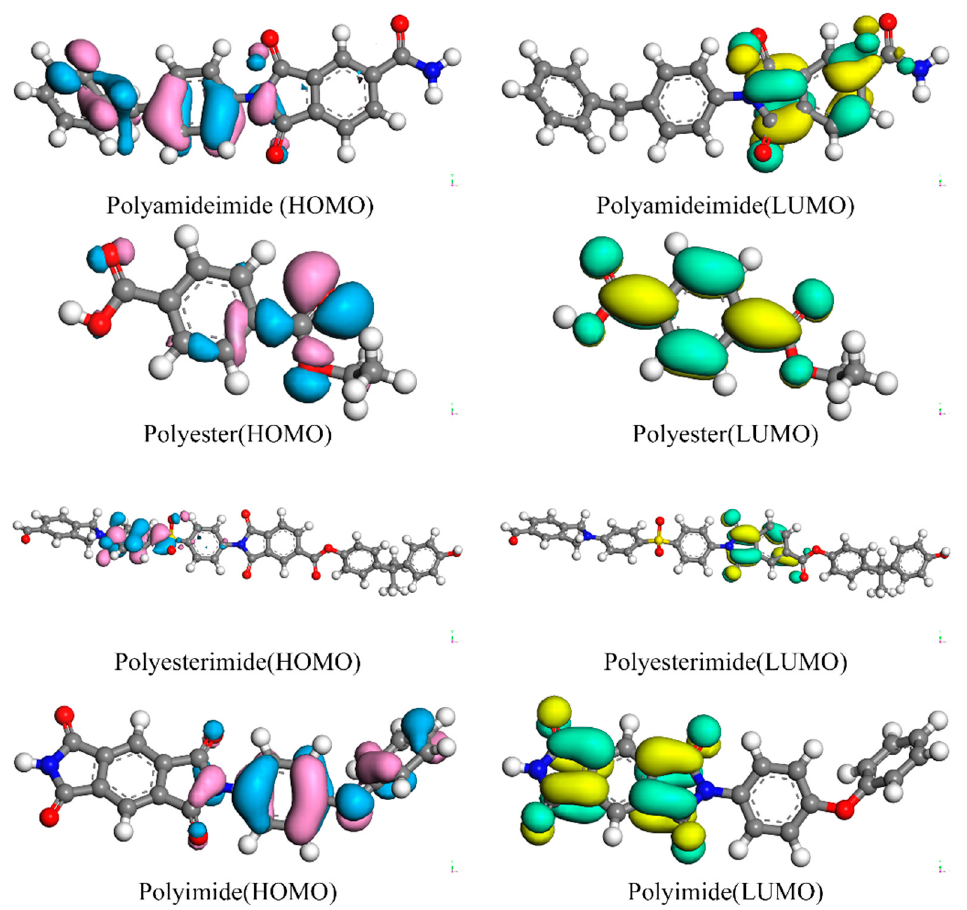
Figure 4. HOMO and LUMO electron cloud distributions for PAI, PET, PEI, and PI. Table 2. HOMO, LUMO and Energy gap of PAI, PET, PEI and PI .